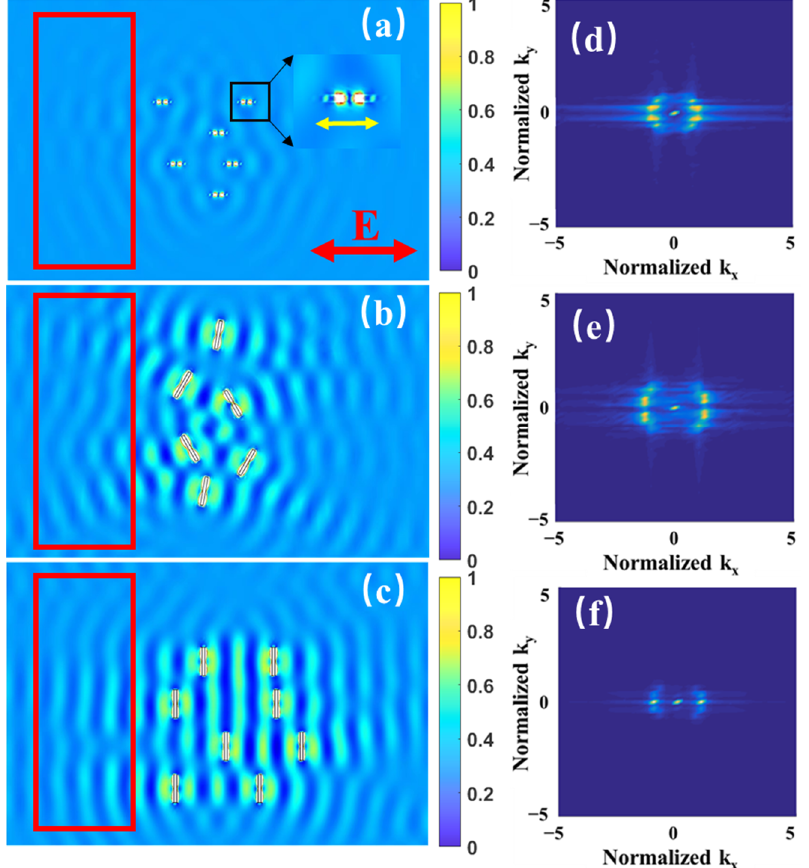
Figure 6. Surface light intensity distribution for different nanogroove orientations. Nanogrooves are ( a ) parallel to laser polarization (initial horizontal HSFLs), ( b ) mostly and ( c ) completely perpendicular to laser polarization (prototype LSFLs). ( d – f ) are the 2D FT images of the light field distributions in the red boxes of ( a – c ). The arrow E shows the laser polarization in ( a ). The color bars in ( a – c ) indicate the normalized light intensity.